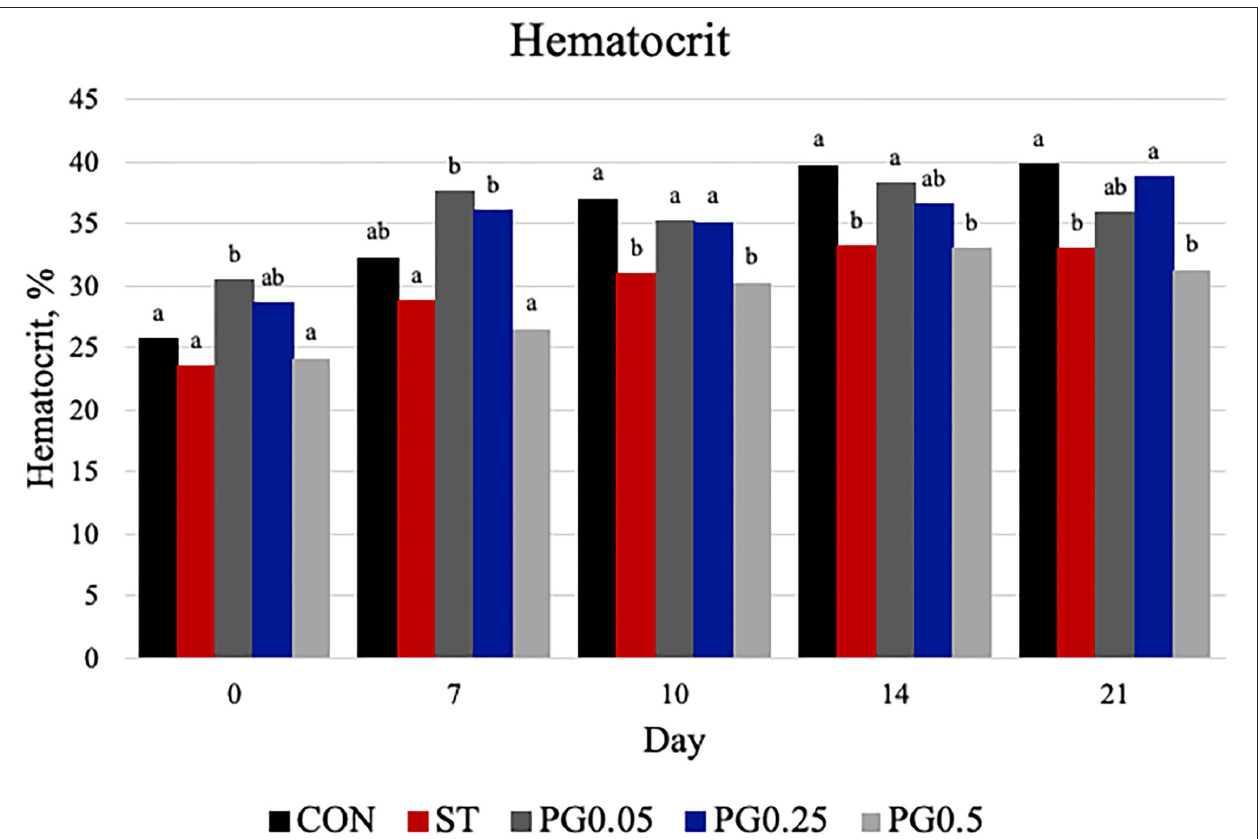
FIGURE 5 | Hematocrit was measured on days 0, 7, 10, 14, and 21. There was a tendency for a treatment × time interaction ( P = 0.0837). There were treatment differences at day 0 ( P = 0.0083), day 7 ( P = 0.0057), day 10 ( P = 0.272), day 14 ( P = 0.019), and day 21 ( P = 0.0037). On day 0, treatment PG0.05 was increased when compared to ST, CON, and PG0.5 ( P ≤ 0.023); PG0.25 was increased when compared to ST and PG0.5 ( P ≤ 0.025). On day 7, treatment PG0.05 was increased compared to CON, ST, and PG0.5 ( P ≤ 0.0135) ; PG0.25 was increased compared to ST and PG0.5 ( P ≤ 0.0135); CON was increased when compared to ST ( P = 0.063). On day 10, treatments PG0.5 and ST were decreased compared to all other treatments ( P ≤ 0.4 96). On day 14, treatment PG0.05 was increased compared to ST and PG0.5 ( P ≤ 0.0502); CON was increased when compared to ST and PG0.5 ( P ≤ 0.0095). On day 21, treatment PG0.5 was decreased when compared to PG0.05, PG0.25, and CON ( P ≤ 0.0695); ST was decreased when compared to CON and PG0.25 ( P ≤ 0.0245). Largest SEM are reported as percentage and include 2.036, 3.192, 2.423, 2.362, and 2.442 for days 0, 7, 10, 14, and 21, respectively. Bars with different superscripts are statistically